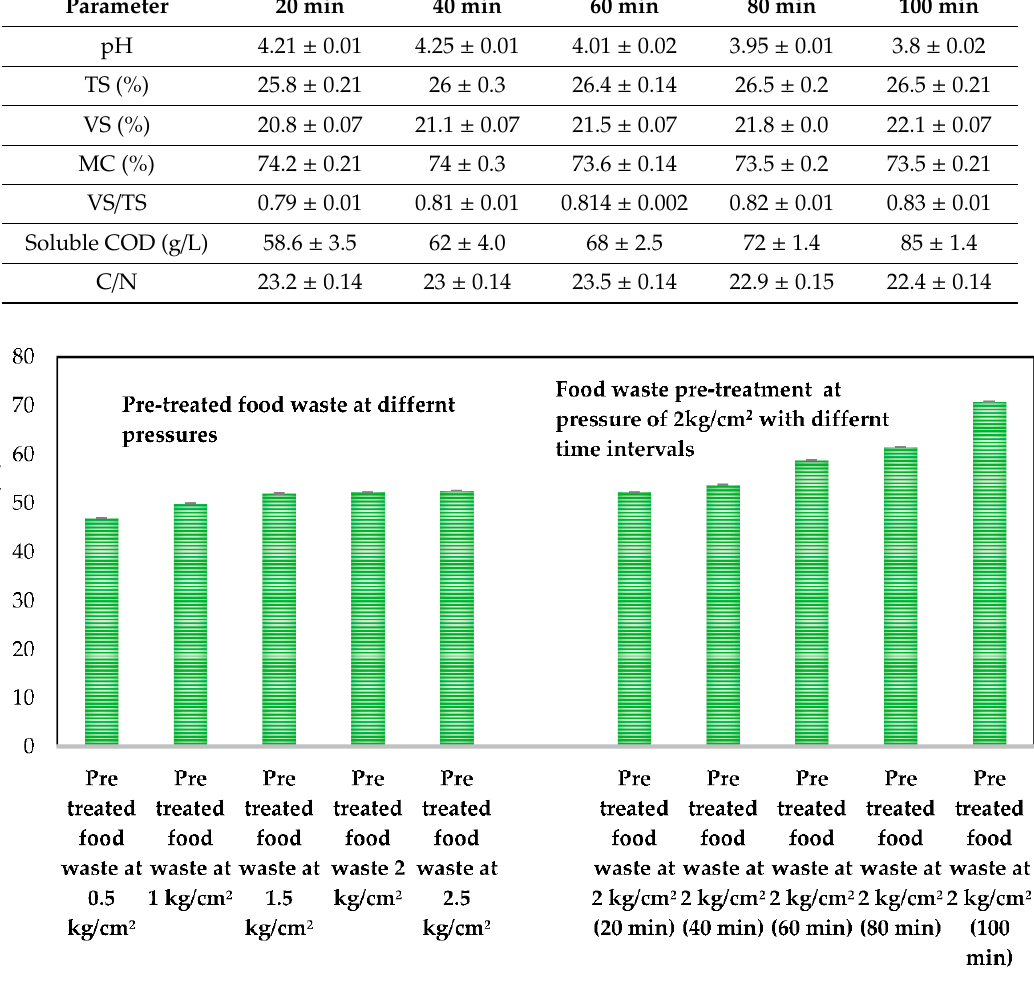
Table 4. Physicochemical characteristics of pretreated food waste at 120 °C and 2 kg/cm 2 for different time intervals.